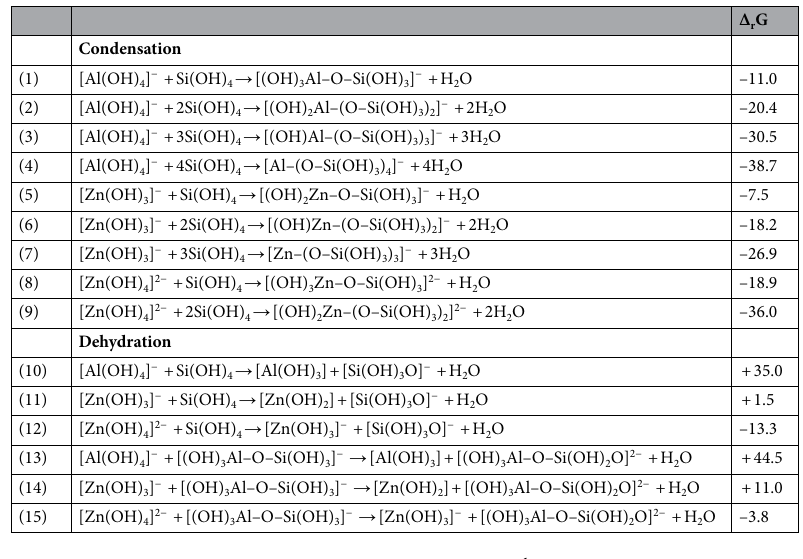
Table 1. Gibbs free energy of reaction (Δ r G. in kcal mol −1 ) computed at the